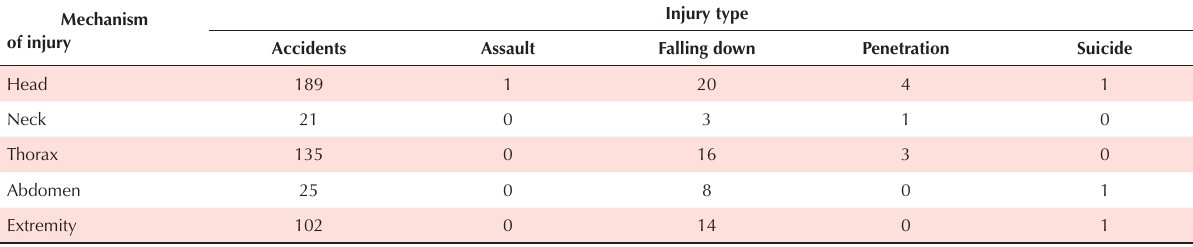
Table 2. The frequency of associated injuries by mechanism of injury Mechanism of injury